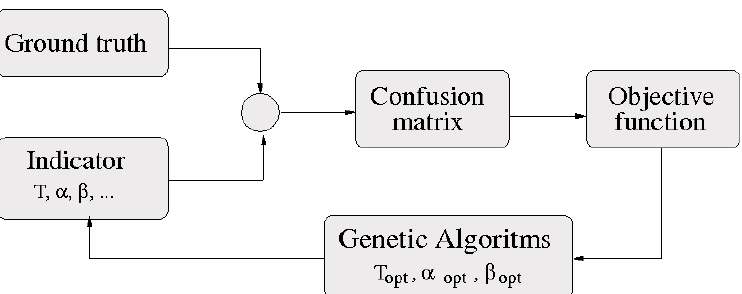
Figure 8. Optimization